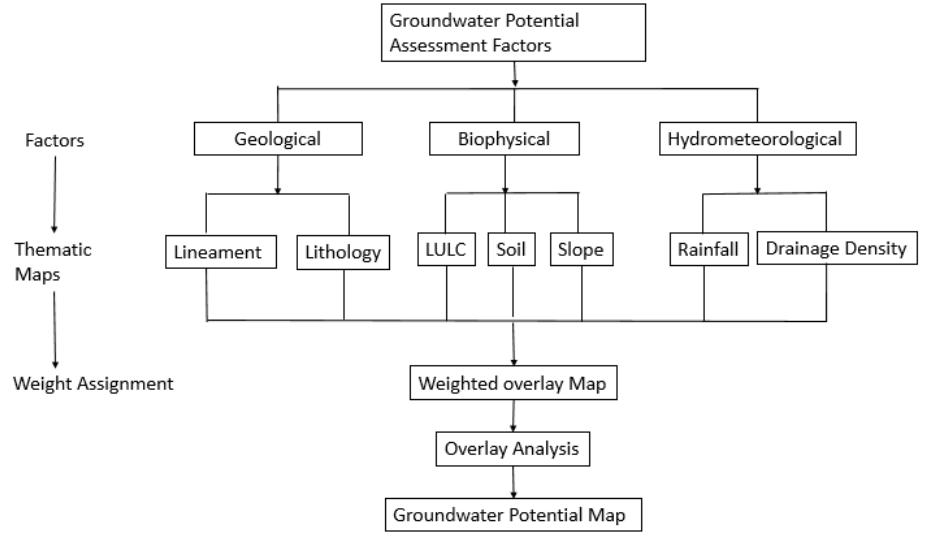
Figure 2. Methodological approach.